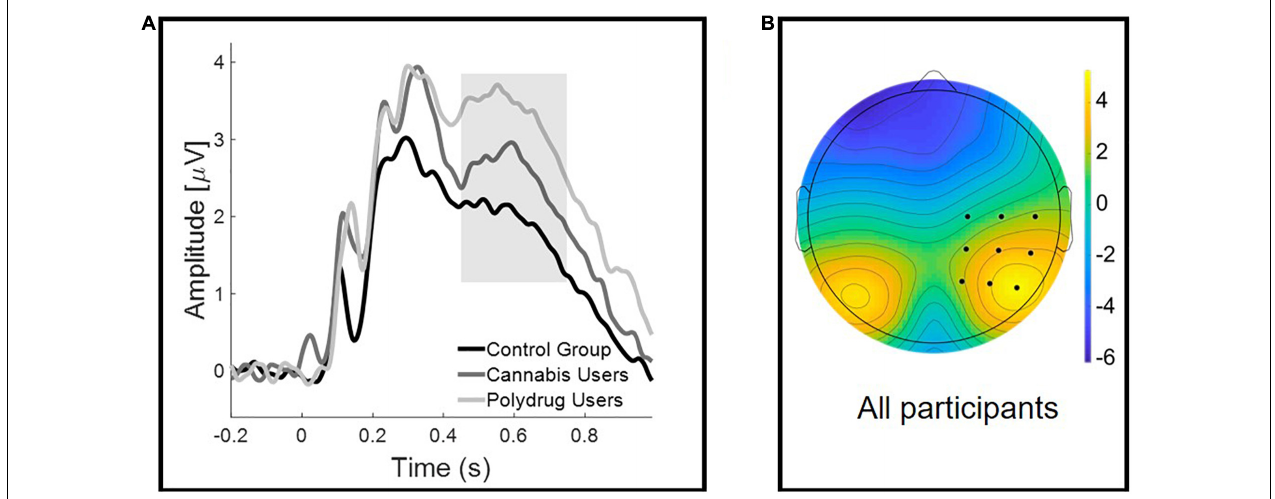
FIGURE 2 | Group differences in the Late Positive Component (LPC). (A) Grand-averaged waveforms at a representative right centro-occipital cluster for correctly recognized images. The shaded area represents the late (450–750 ms) time window used for the analyses. (B) Scalp topographies of the mean activity in 450–750 ms time window.